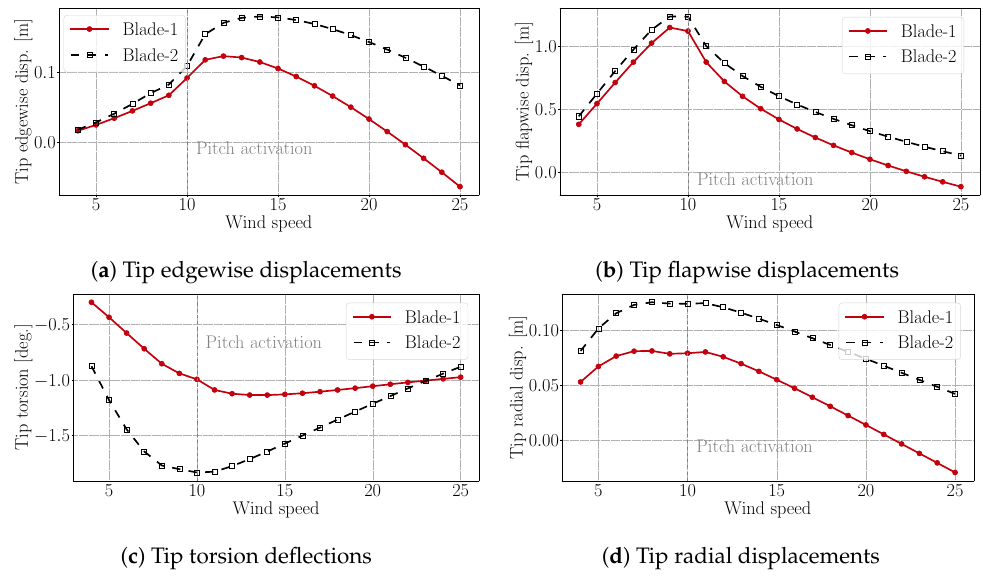
Figure 13. Blade tip edgewise ( a ) and flapwise ( b ) displacements, torsion deflections ( c ), and radial displacements ( d ) for steady wind speeds.